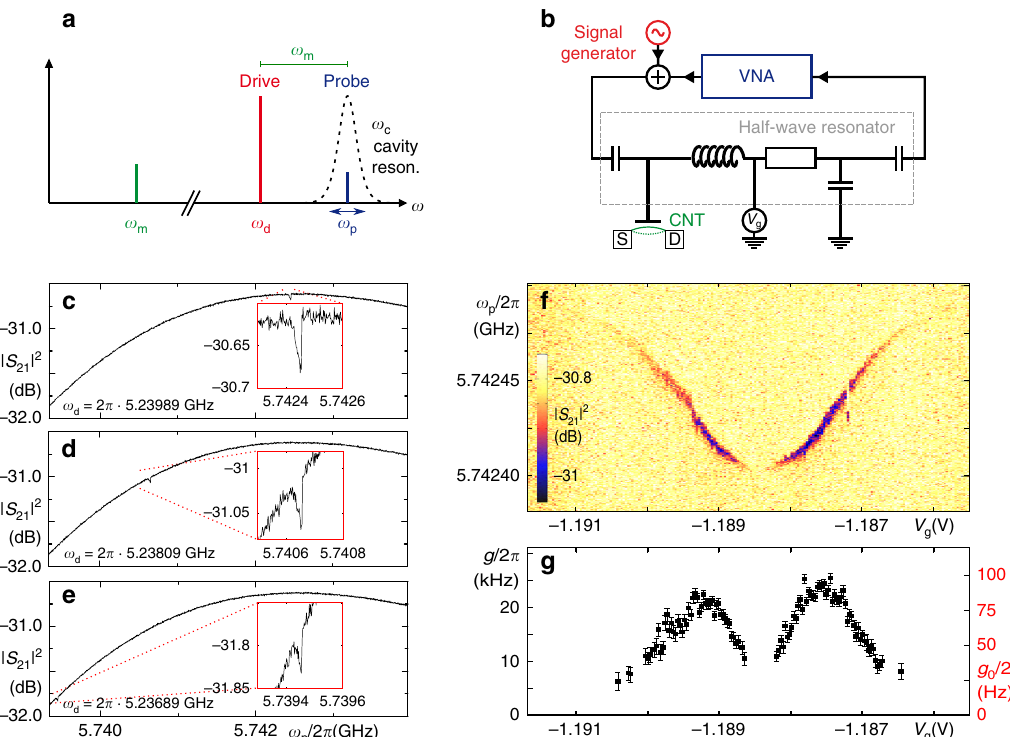
Fig. 2 Optomechanically induced transparency (OMIT) in the Coulomb blockade regime. a Frequency scheme and b detection setup of an OMIT measurement. A strong drive signal at ω d = ω c − ω m pumps the microwave cavity; the cavity transmission near the cavity resonance ω c is characterized using a superimposed weak probe signal ω p from a vector network analyzer (VNA). Device parameters are: ω c ≃ 2 π ⋅ 5.74 GHz, κ c = 2 π ⋅ 11.6 MHz, ω m ≃ Þj 2 for three different choices of cavity drive frequency ω 2 π ⋅ 502.5 MHz. c – e Probe signal power transmission j S 21 ð ω p detuned ( d , e ). The gate voltage V g = − 1.1855 V is fi xed on the fl ank of a sharp Coulomb oscillation of conductance; V sd = 0. f Probe signal transmission as in c – e , now for a fi xed cavity drive frequency ω d = 2 π ⋅ 5.23989 GHz and varied gate voltage V g across a Coulomb oscillation. The depth of the OMIT feature allows the evaluation of the optomechanical coupling g ( V g ) at each gate voltage value. g Optomechanical coupling g ( V g ) (left axis) and p ffiffiffiffiffi Þ ¼ g ð V Þ = (right axis), extracted from the data of f ; n c = 67,500. Error bars indicate the standard error of corresponding single photon coupling g 0 ð V n g g c the fi t resonance of the cavity becomes visible in the measurements of Fig. 2c – e. It occurs due to destructive interference of the probe fi eld with optomechanically upconverted photons of the drive − ω = ω fi eld, when the two-photon resonance condition ω p d m is ful fi lled 22 , and shifts in frequency as expected when ω d is detuned from the precise red sideband condition, see Fig. 2d, e. Fitting the OMIT feature allows to extract the optomechanical coupling p ffiffiffiffiffi ð ∂ ω = ∂ x Þ x , describing the cavity detuning parameter g ¼ n c c zpf per displacement of the mechanical harmonic oscillator 14,22 , see Supplementary Note 9 for details. Surprisingly, from Fig. 2c, ¼ one obtains a single-photon coupling on the order of g p ffiffiffiffiffi 0 (cid:2) 2 π (cid:3) 100 Hz. g = n c